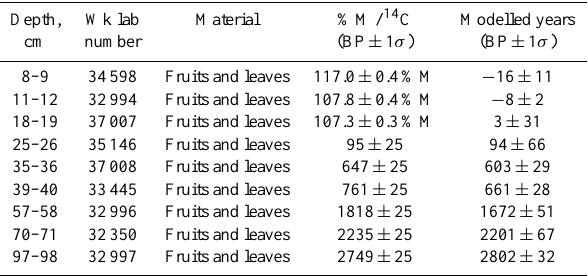
Table 1. Radiocarbon and modelled calibrated ages using SHCal13 (Hogg et al., 2013) and Bomb04SH (Hua and Barbetti, 2004) using the P_sequence and Outlier analysis option in OxCal 4.2 (Bronk Ramsey and Lee, 2013; Ramsey,